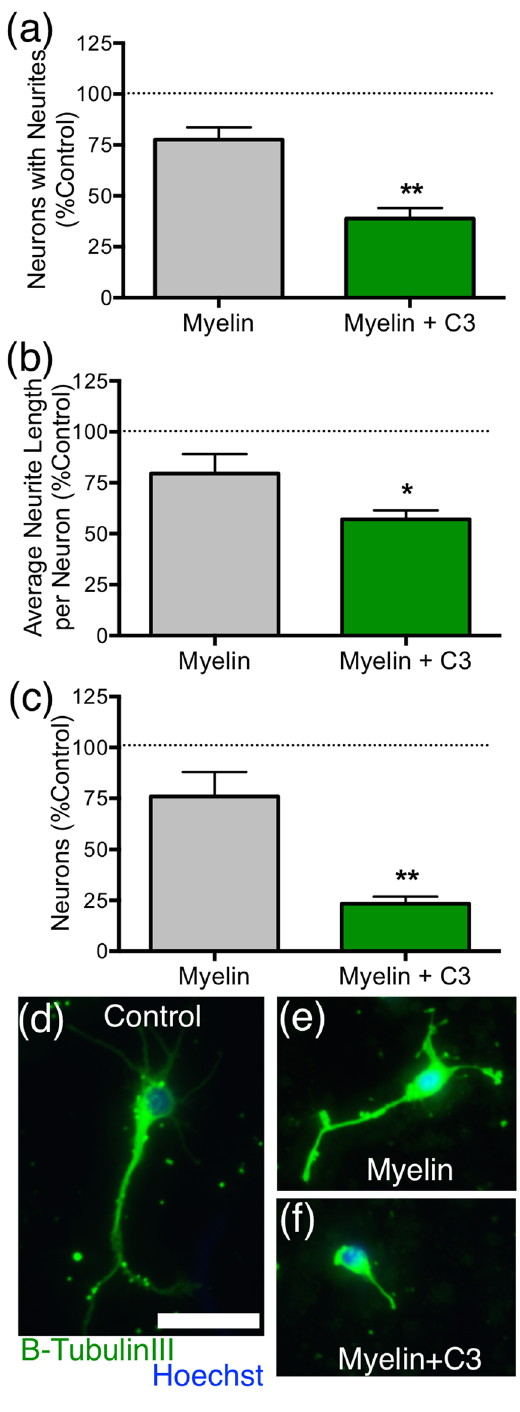
Figure 3. Complement C3 exacerbated myelin-mediated neurite outgrowth inhibition for cultured cortical neurons. ( a ) Percentage of neurons with neurites, ( b ) average neurite length per neuron, and ( c ) number of neurons were each graphed as a percent of the values for untreated wells (control, marked by dotted line) from the same experiment (% control). Myelin plus C3 was significantly more inhibitory to neurite growth and neuron number than myelin alone. Note that neurite growth and number in myelin treated wells is < 100% of untreated controls, as expected. Immunofluorescent images of cultured cortical neurons grown in either ( d ) control, ( e ) myelin, or ( f ) myelin + C3 conditions. Immunofluorescent labeling for β -TubulinIII + neurons (green) and Hoescht nuclear counterstain (blue). Scale bars ( d , e , f ) = 30 μ m. Mean ± SEM. * p < 0.05, ** p < 0.01 Student’s t-test (2-tailed) vs. myelin alone. N = 4 (myelin); N = 3 (myelin + C3) independent biological